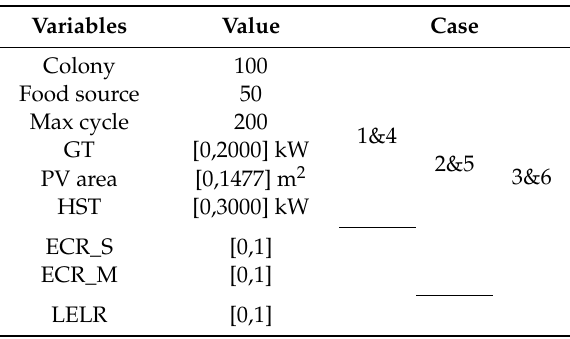
Table A6. Parameters of the ABC